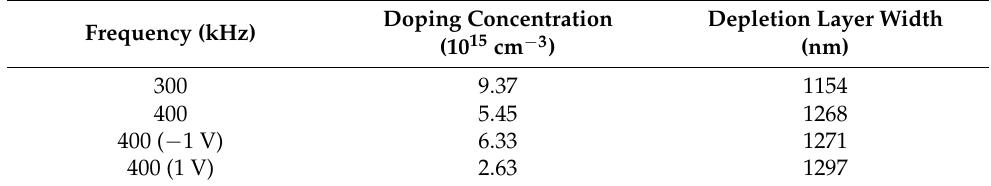
Table 1. Doping concentration and depletion layer width for the CIGS solar